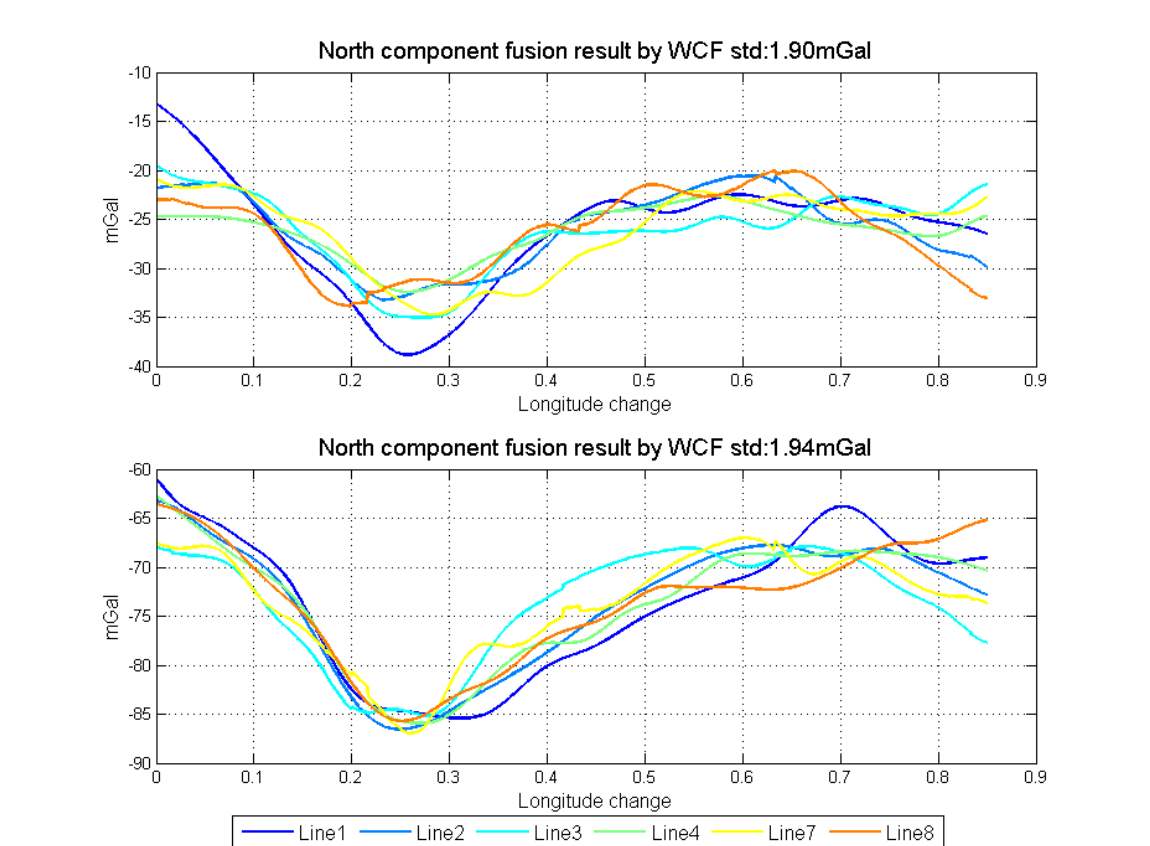
Figure 20. Data fusion results by WCF.